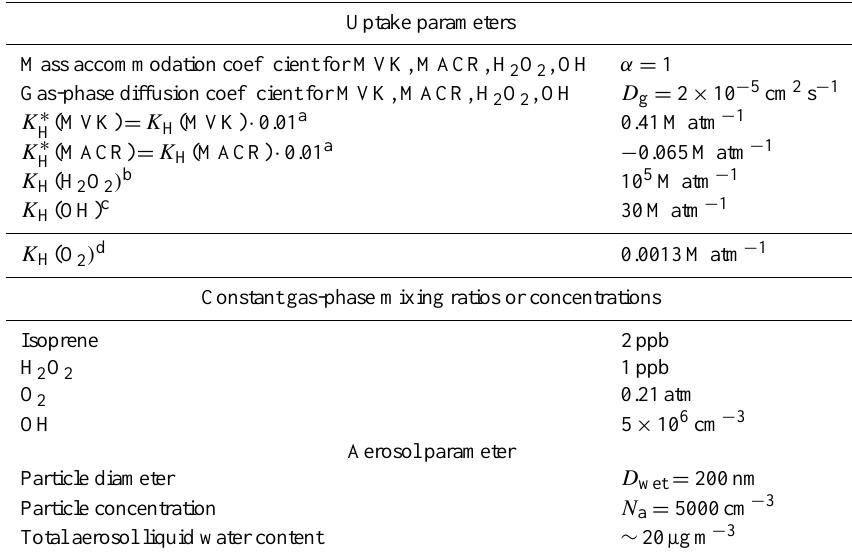
Table 2. Uptake parameters and initial conditions for box model multiphase simulations. Uptake parameters Mass accommodation coefficient for MVK, MACR, H 2 O 2 , OH α = 1 Gas-phase diffusion coefficient for MVK, MACR, H 2 O 2 , OH D g = 2 × 10 − 5 cm 2 s − 1